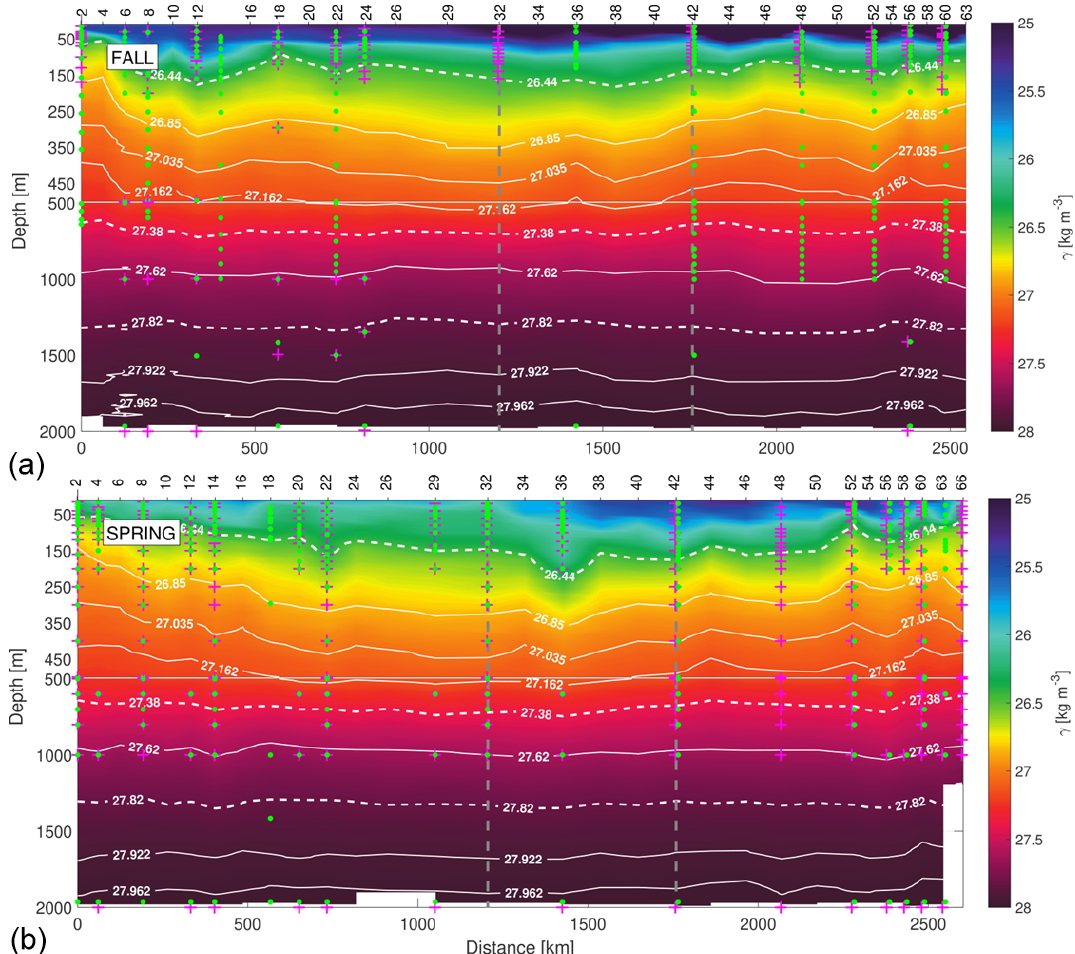
Figure 2. The γ n vertical sections during fall (a) and spring (b) cruises. White dashed isoneutrals limit the different water type layers. The direction chosen for the representation of the transects is the course of the vessel. Distance is calculated with respect to the first station (2). The section is divided into three transects: the northern transect from east to west (from station 2 to 32), the western transect from north to south (from station 32 to 42) and the southern transect from west to east (from stations 42 to 63–66). The three transects are separated by two vertical grey dashed lines located at stations 32 and 42. The sampling points of INs and DOC used in this work are also represented by pink crosses and green dots,